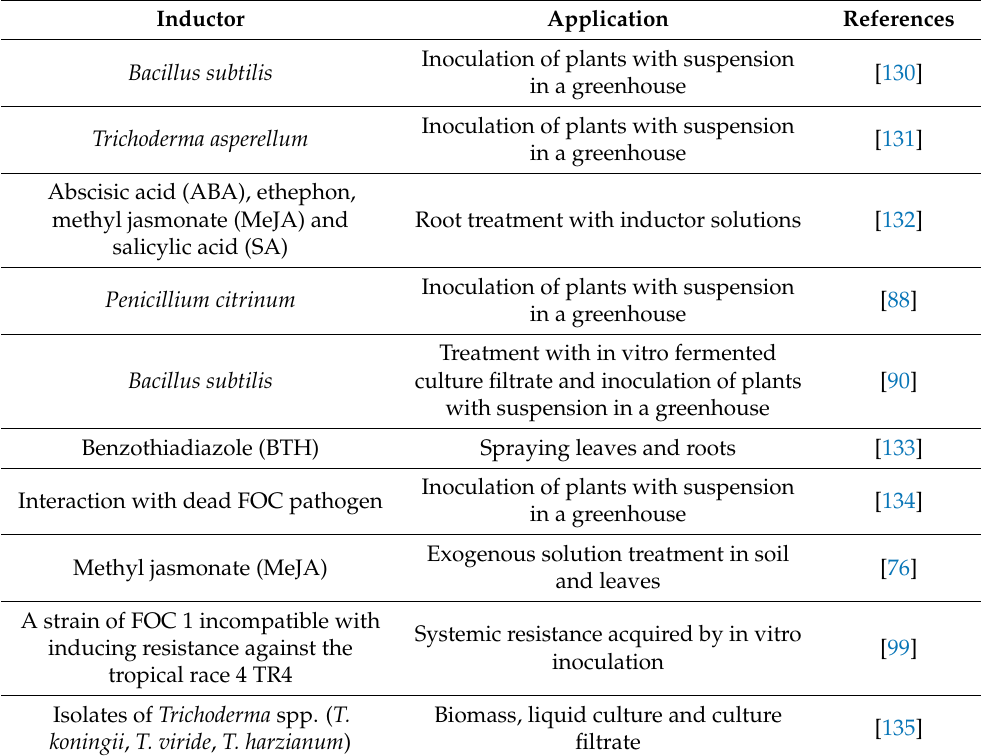
Table 8. Resistance-inducing agents in banana plants reported in studies on improvement to Fusarium wilt in the last ten